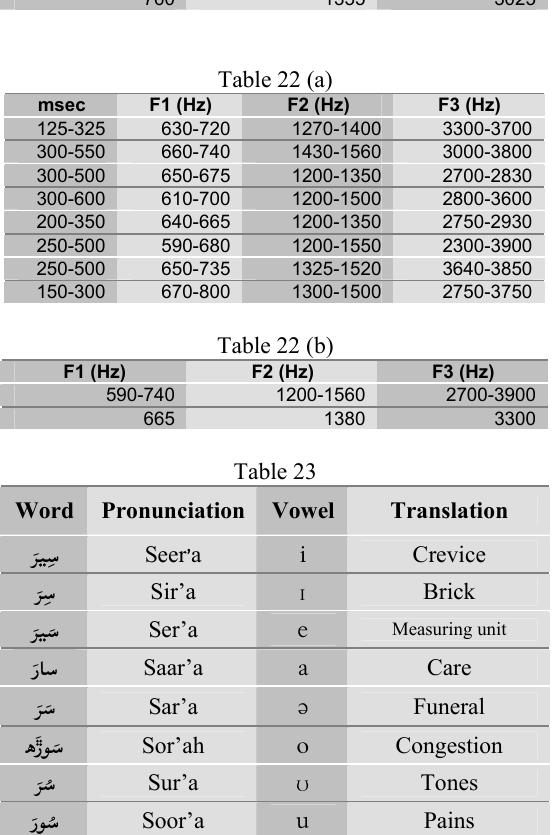
Figure 3: The Vowel